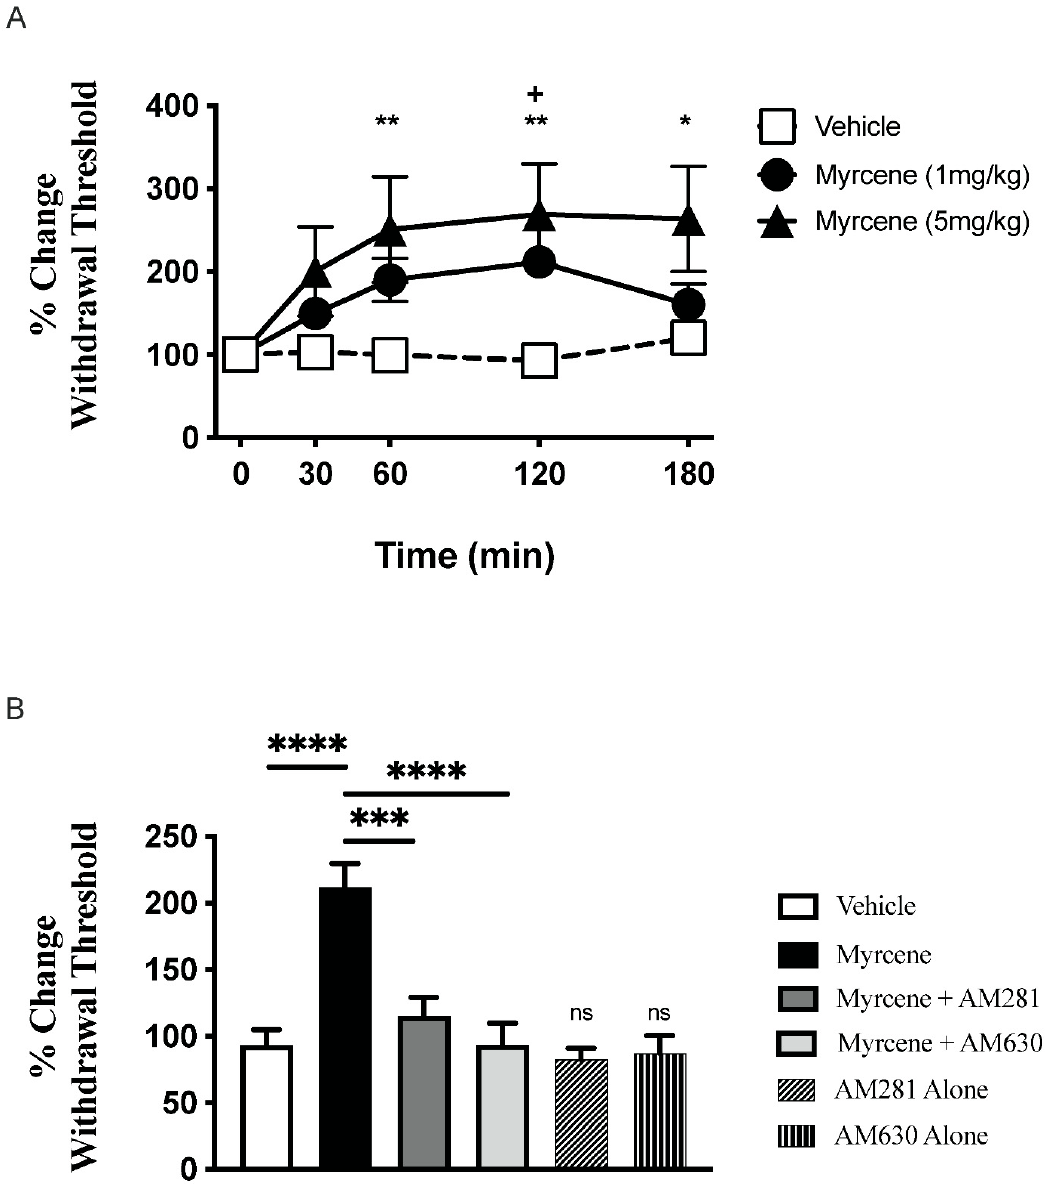
timepoint where the 1 mg/kg dose improved nociception by 211.0 ± 17.93% and the 5 mg/kg dose 269.3 ± 63.27% (Figure 1A). Focusing on the 120 min timepoint (Figure 1B), (Figure 1B), the analgesic effect of myrcene was blocked by pre-treatment with either the the analgesic effect of myrcene was blocked by pre-treatment with either the CB 1 -receptor CB 1 -receptor antagonist AM281 ( p < 0.001 one factor RMANOVA with Bonferroni’s post antagonist AM281 ( p < 0.001 one factor RMANOVA with Bonferroni’s post hoc test; n = 8 hoc test; n = 8 animals/group) or the CB 2 -receptor antagonist AM630 ( p < 0.0001). Neither animals/group) or the CB 2 -receptor antagonist AM630 ( p < 0.0001). Neither antagonist antagonist alone had any effect on joint pain. alone had any effect on joint pain.